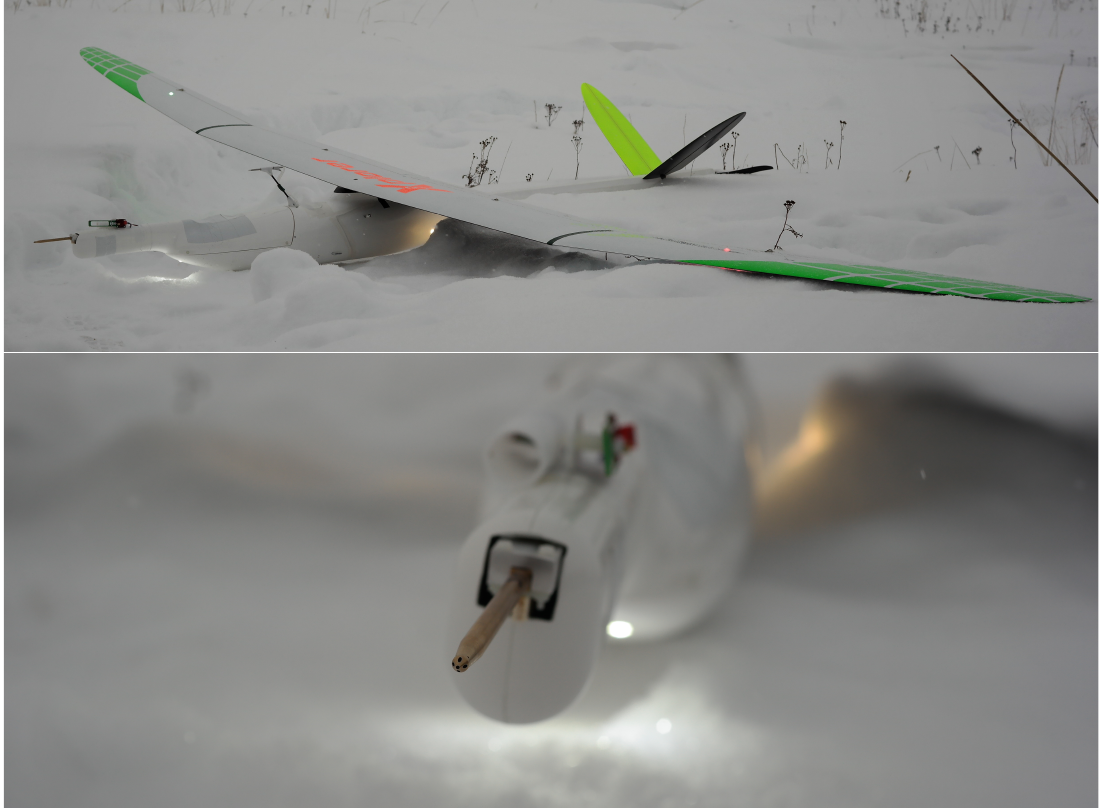
Figure 3. MASC with enlightening ( top ). Picture of the probe tip ( bottom